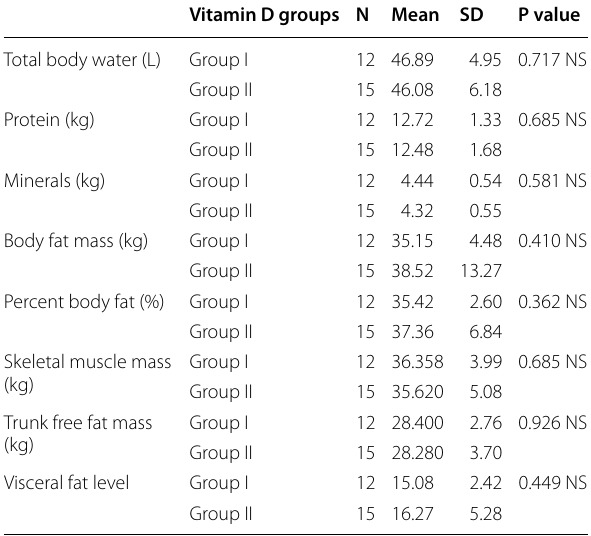
Table 2 Vitamin D status in relation to InBody bioelectrical impedance among obese male medical student